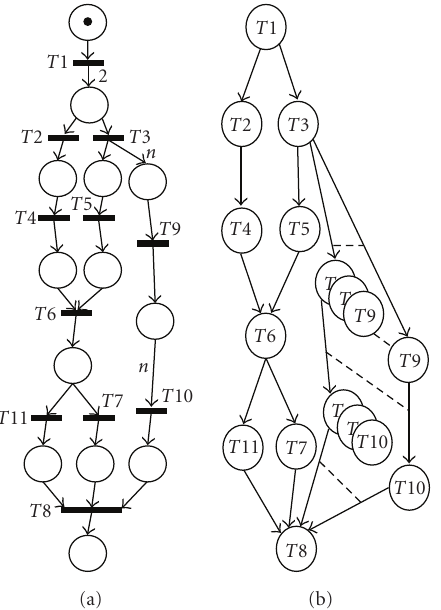
Figure 5: (a) A Petri net representation of the example of Figure 4. (b) A DFG representation of the example of Figure 4.